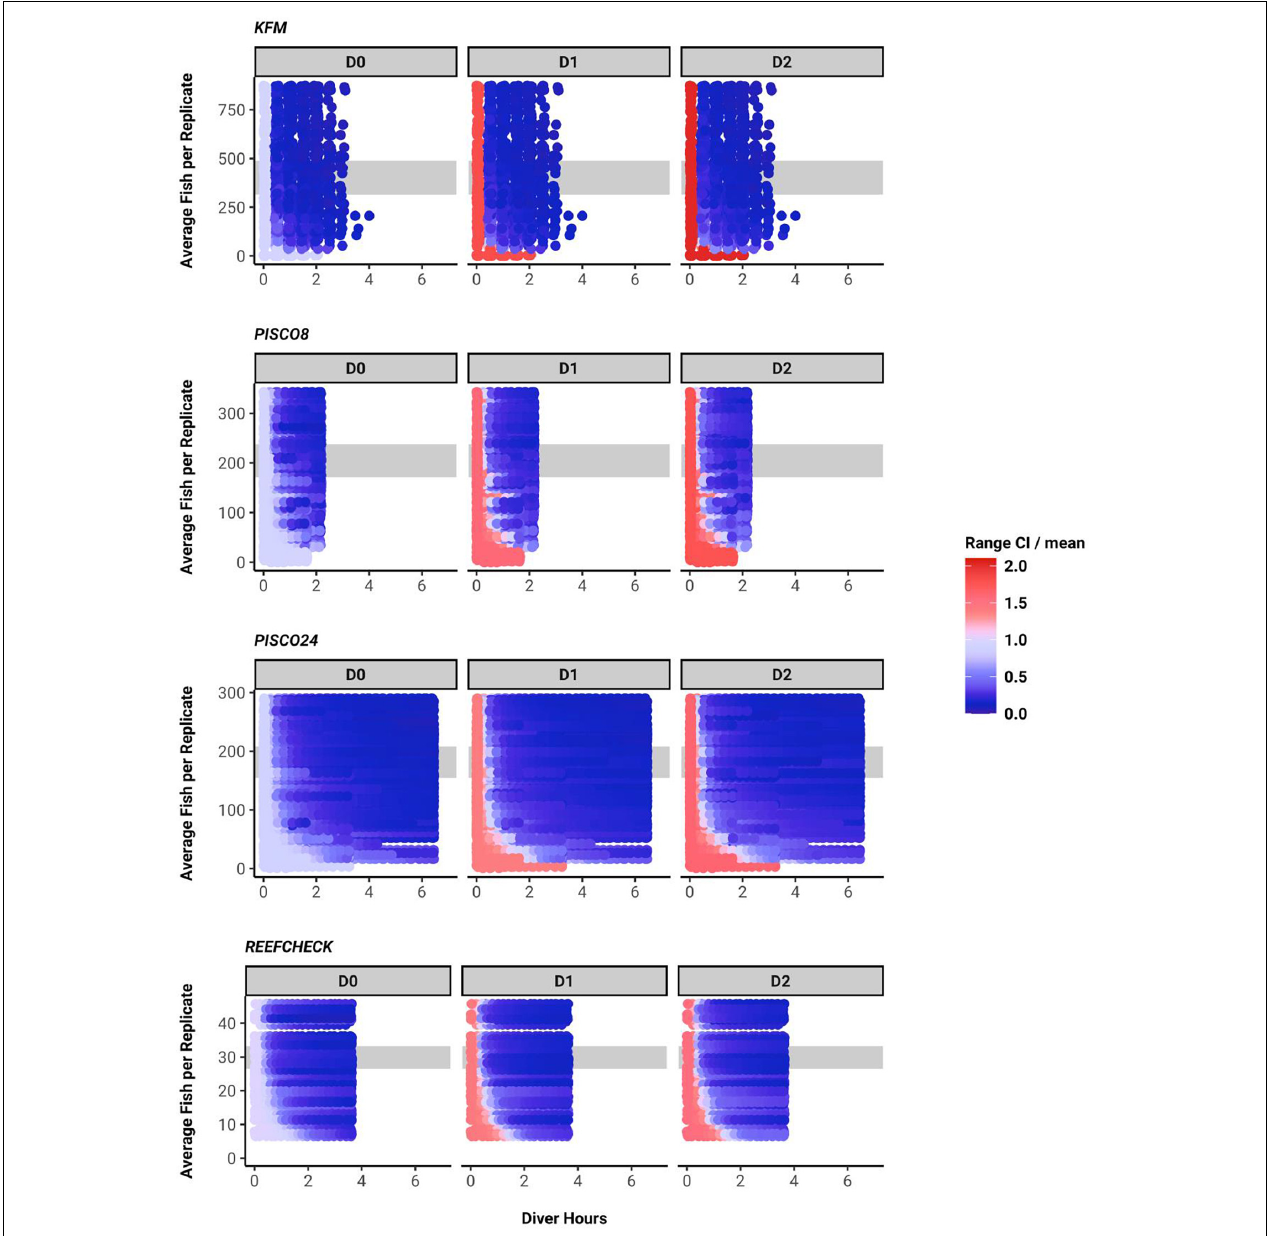
FIGURE 4 | Confidence interval width for each diversity metric, plotted as across a gradient of sampling effort ( x axis) and as a function of the abundance of fish (of the species recorded) at the site (data truncated at the 80th percentile). Gray band indicates the 40–60th fish density